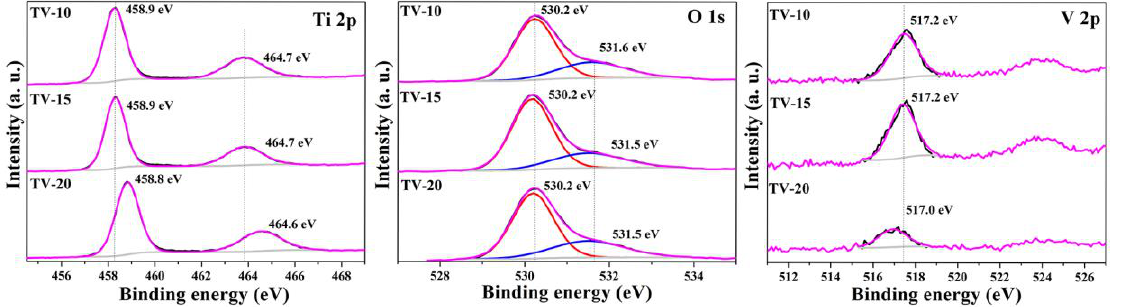
Figure 3. High-resolution XPS spectrums for Ti 2p, O 1s, and V2p for samples TV-10, TV-15, and TV-20.